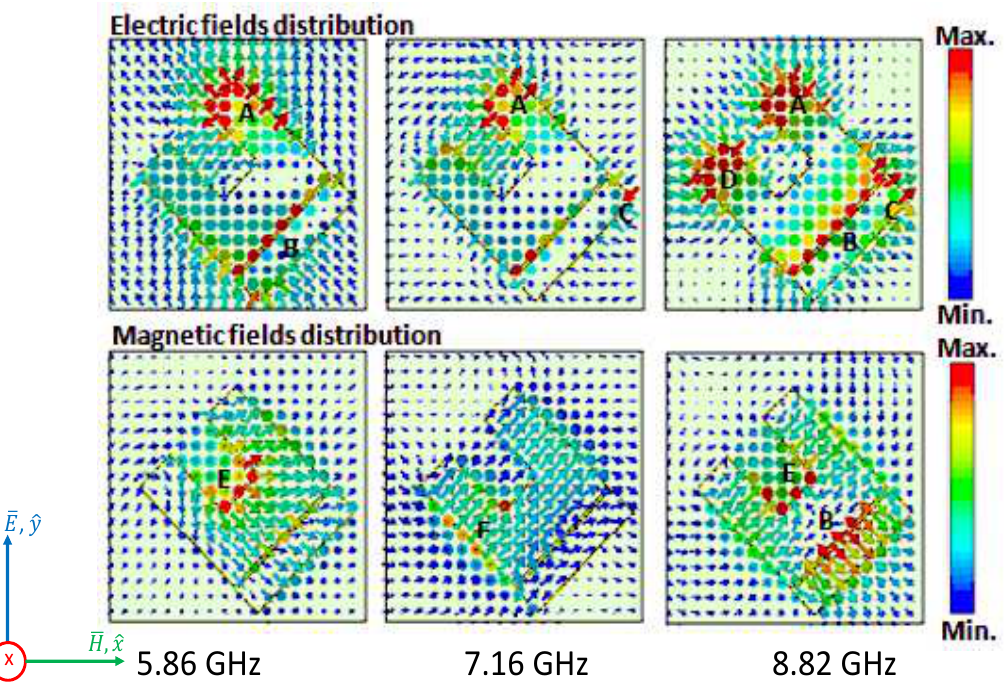
Figure 6. Distribution of electric and magnetic fields on the absorber at 5.86 GHz, 7.16 GHz and 8.82 GHz for a linearly polarized TE wave. Different labeled regions correspond to regions where maximum electric or magnetic fields have been